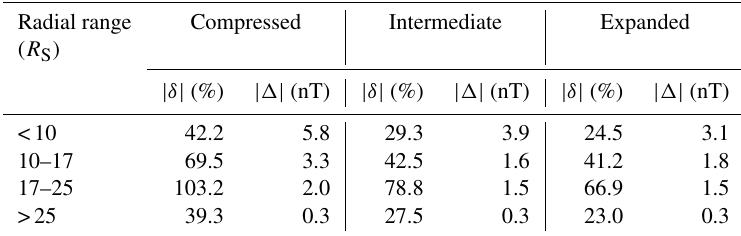
Figure 6. (a) and (b) show results of model field line calculations between the ionosphere and 200 R S down tail for (a) Rev 18 inbound and (b) Rev 18 outbound, as illustrated in Figs. 2–4. The upper panels show field lines traced in the noon-midnight meridian plane in KSM coordinates, for the selected model parameters for these passes on the left and the linear approximations on the right, as given by the parameters above the field line plots. The IMF was assumed equal to zero. The middle panels show the northern ionospheric projections of the field lines that reach x = − 200 R S viewed looking down on the north pole again for the selected parameters on the left (green line) and the linear approximations on the right (red line). These are compared in the lower panel. (c) and (d) show results of model field line calculations between the ionosphere and 200 R S down tail for (c) Rev 145 inbound and (d) Rev 145 outbound, in the same format as (a) and (b) . Table 6. Mean values of the absolute | (cid:49) | and relative | δ | fit errors for the apoapsis passes from Rev 23 outbound to 26 inbound in four radial ranges, for three assumed states of the magnetosphere, compressed, intermediate, and expanded, using the linear approximation model parameters in Table